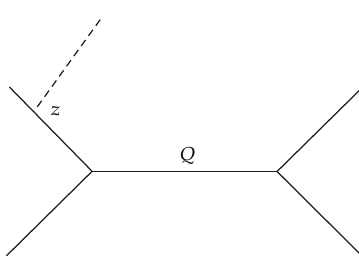
Figure 14: Brane associated to the external leg of a toric diagram (cid:4) of a conifold in this particular case (cid:5) . Closed string parameter is denoted by Q and open string parameter by z